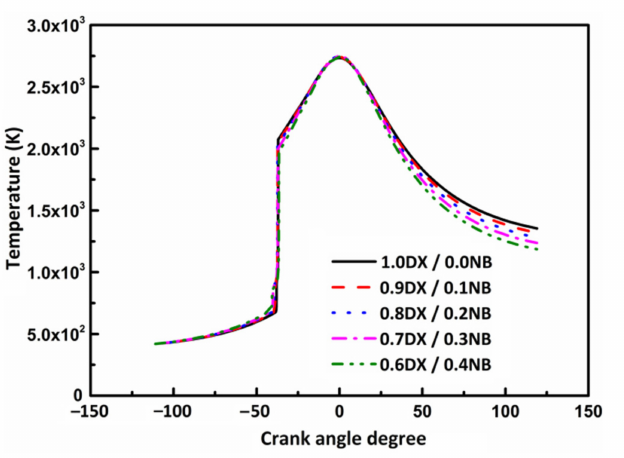
Figure 10. Effect of DX and n-butanol mixing ratio on combustion temperature in cylinder.